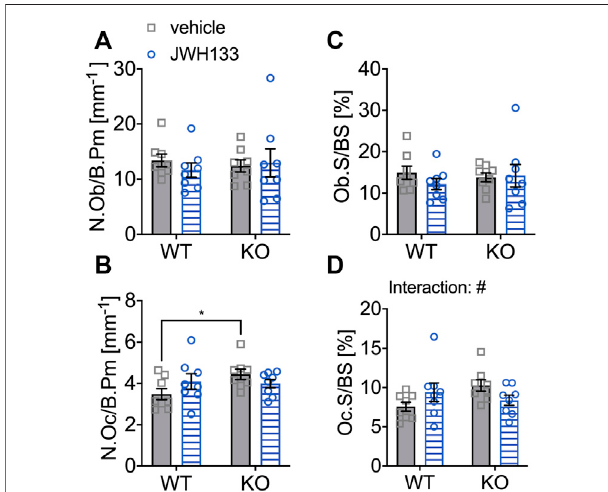
FIGURE 9 | 6-month aged WT and p62 KO mice showed an opposing effect on osteoclasts after prolonged treatment with JWH133. (A) Number of osteoblasts per bone perimeter (N.Ob/B.Pm) was comparable in vehicle- and JWH133-treated mice and showed no effect of genotype or treatment. (B) Number of osteoclasts per bone perimeter (N.Oc/B.Pm) was signi fi cantly increased in p62 KO mice (vehicle) compared to WT mice (vehicle). The treatment affected genotypes in an opposite way. (C) Osteoblast surface per bone surface (Ob.S/BS) was not altered between genotypes and was not affected by the treatment. (D) Osteoclasts per bone surface (Oc.S/BS) were weakly increased in WT mice and reduced in p62 KO mice by the treatment with JWH133 leading to a signi fi cant effect of interaction. Data were analyzed by using ordinary two-way ANOVA and Bonferroni adjusted p values, * p < 0.05, ** p < 0.01, *** p < 0.001. All error bars show mean ± SEM. Squares and circles represent individual data points. WT vehicle N = 8, KO vehicle N = 8, WT JWH133 N = 8, KO JWH133 N =